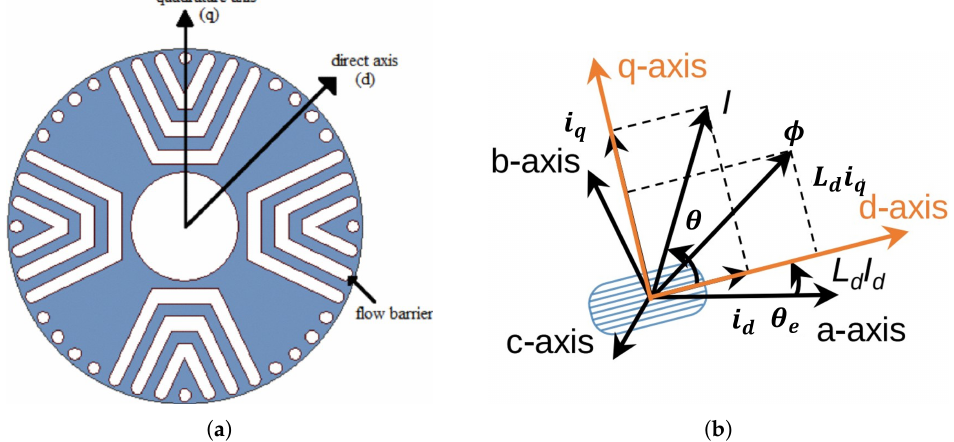
Figure 2. ( a ): Cross section of an exemplary SynRM with four poles. ( b ): Transformation of the system in synchronous ( dq ) reference frame